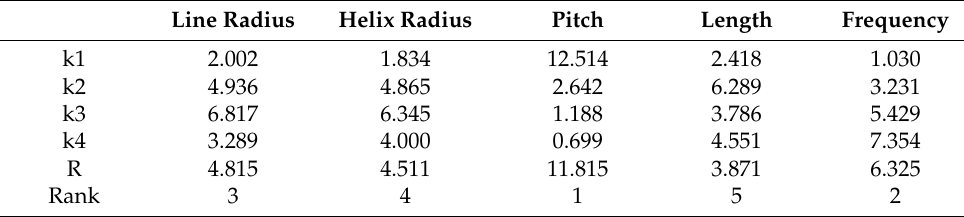
Table 5. The main effect of five parameters acting on the K.